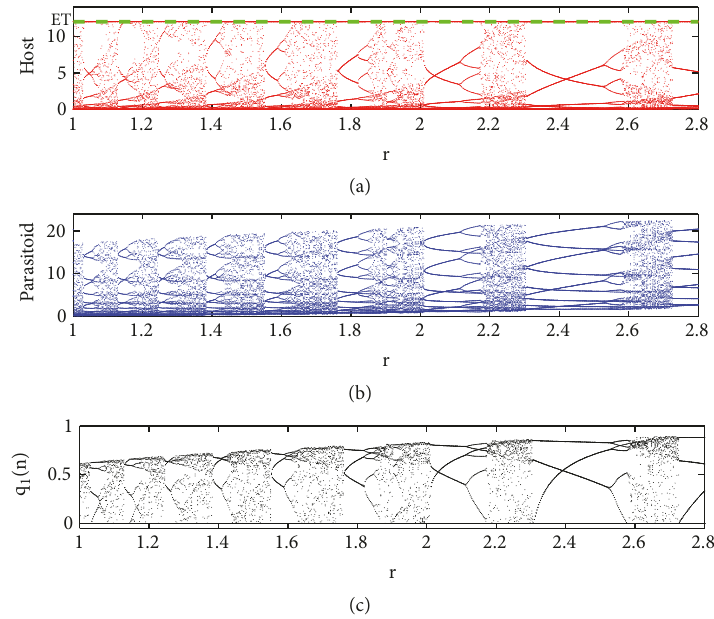
Figure 8: Bifurcation diagram of model (23) with 𝑟 . Parameters are fixed as 𝑎 = 0.25 , 𝜎 = 0.6 , 𝑞 𝑚𝑎𝑥 2 = 0.1 , 𝜃 2 = 1 , 𝜏 = 2 , 𝐸𝑇 =